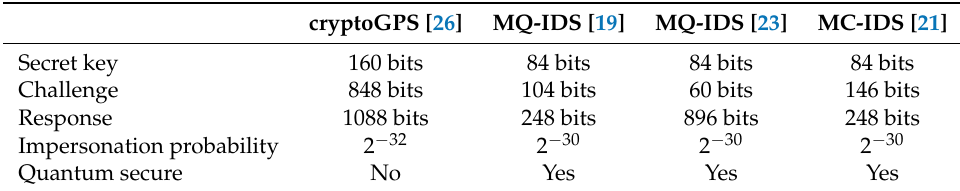
Table 2. Comparison of the identification schemes and